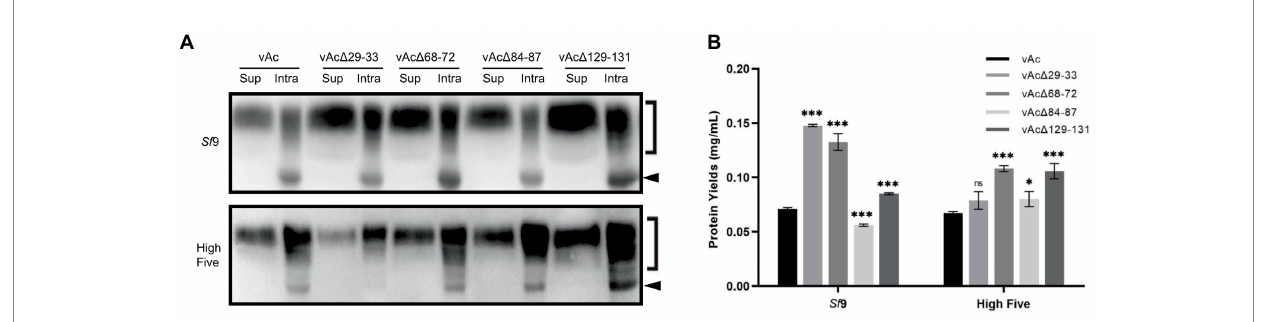
FIGURE 5 Expression of glycoprotein OD-Fc in Sf 9 and High Five cells. (A) Detection of the intracellular and secreted OD-Fc by Western blot at 5 dpi. The unmodified target protein band is indicated by a black arrow, and the glycosylated form is indicated by a right square bracket. The OD-Fc protein was probed by HRP-conjugated anti-Human antibody in Western blot analysis. (B) Quantification of the level of OD-Fc secreted in the cell culture supernatant by ELISA at 5 dpi. Data were presented as the means ±SD of three replicates. ns: not significant, * p < 0.05, ** p < 0.01, *** p < 0.001 vs.